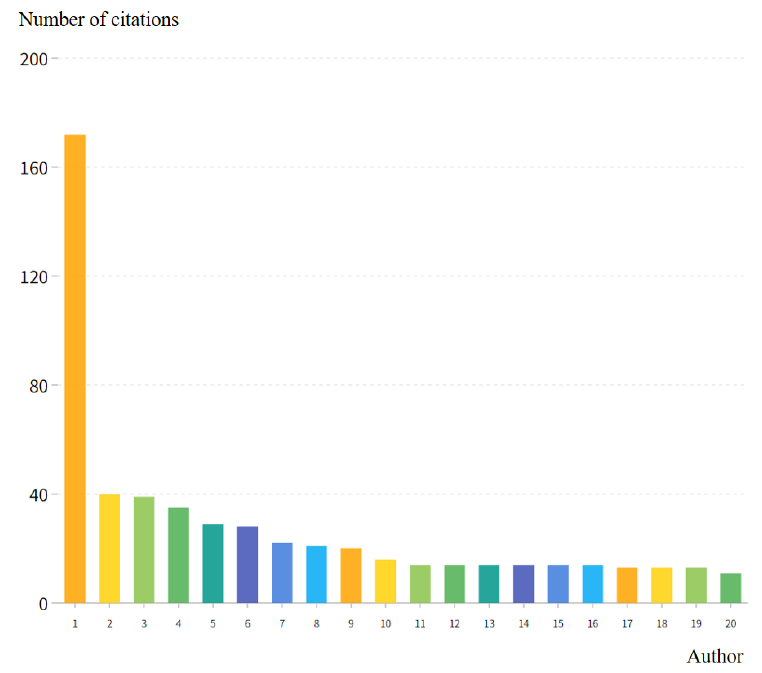
Figure 4. Local citation times of authors in the field of rural revitalization from 1991 to 2020 (top 10). Note: 1, Liu YS; 2, Li YR; 3, Zhou Y; 4, Li YH; 5, Long HL; 6, Westlund H; 7, Cui WG; 8, Wang YS; 9, Yang YY; 10, Zheng XY; 11, Chen L; 12, Guo YQ; 13, Lai ZX; 14, Lin YL; 15, Zhou CZ; 16, Zhu C; 17, Fu HF; 18, Li JT; 19, Li XZ; 20, Cheng MY.